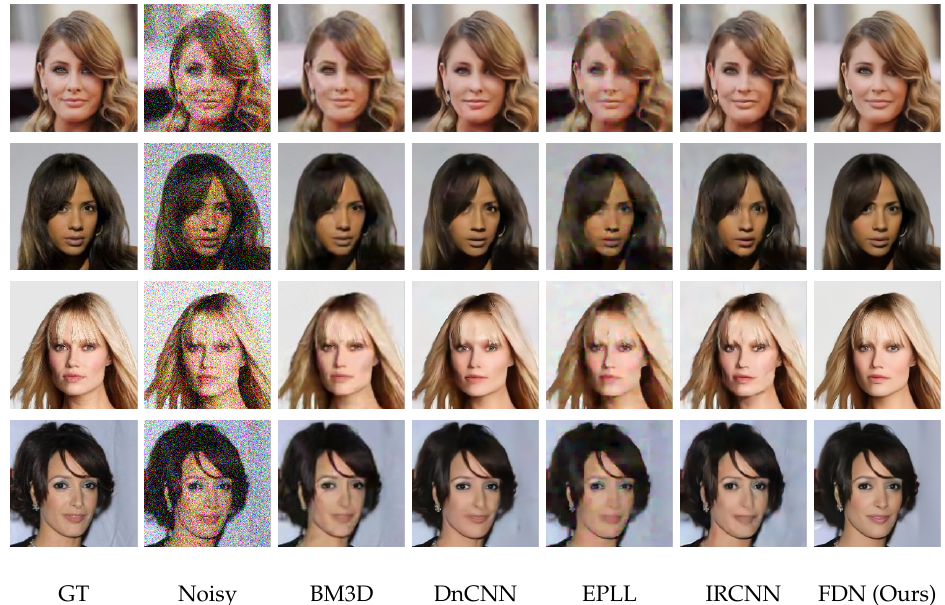
Figure 6. Image denoising results of FDN on CelebA dataset with σ = 50 against competitive methods. Our network produces results close to the ground-truth without any kind of deformation or artifact. The effects are best viewed